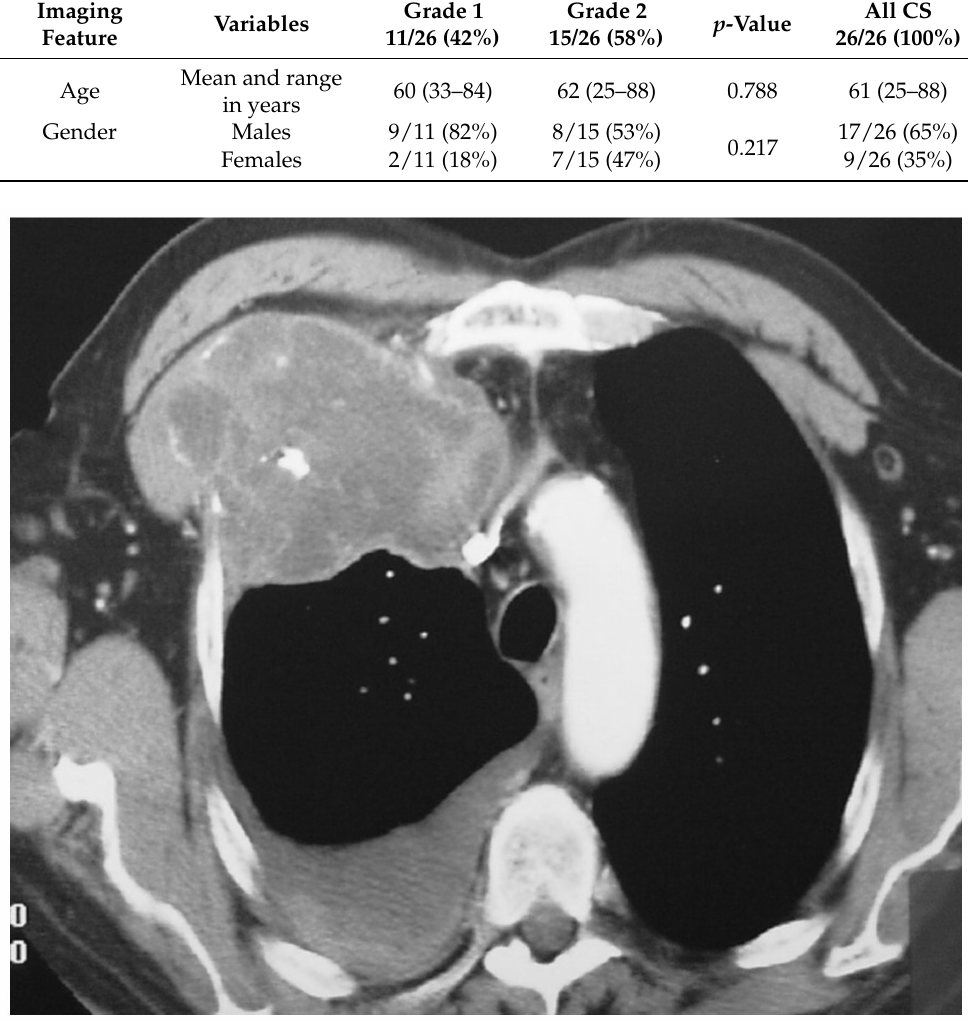
Figure 1. A 72-year-old male patient with grade 2 costochondral junction chondrosarcoma. Contrast- enhanced axial chest CT shows a large (90 mm) soft tissue mass at the right costochondral